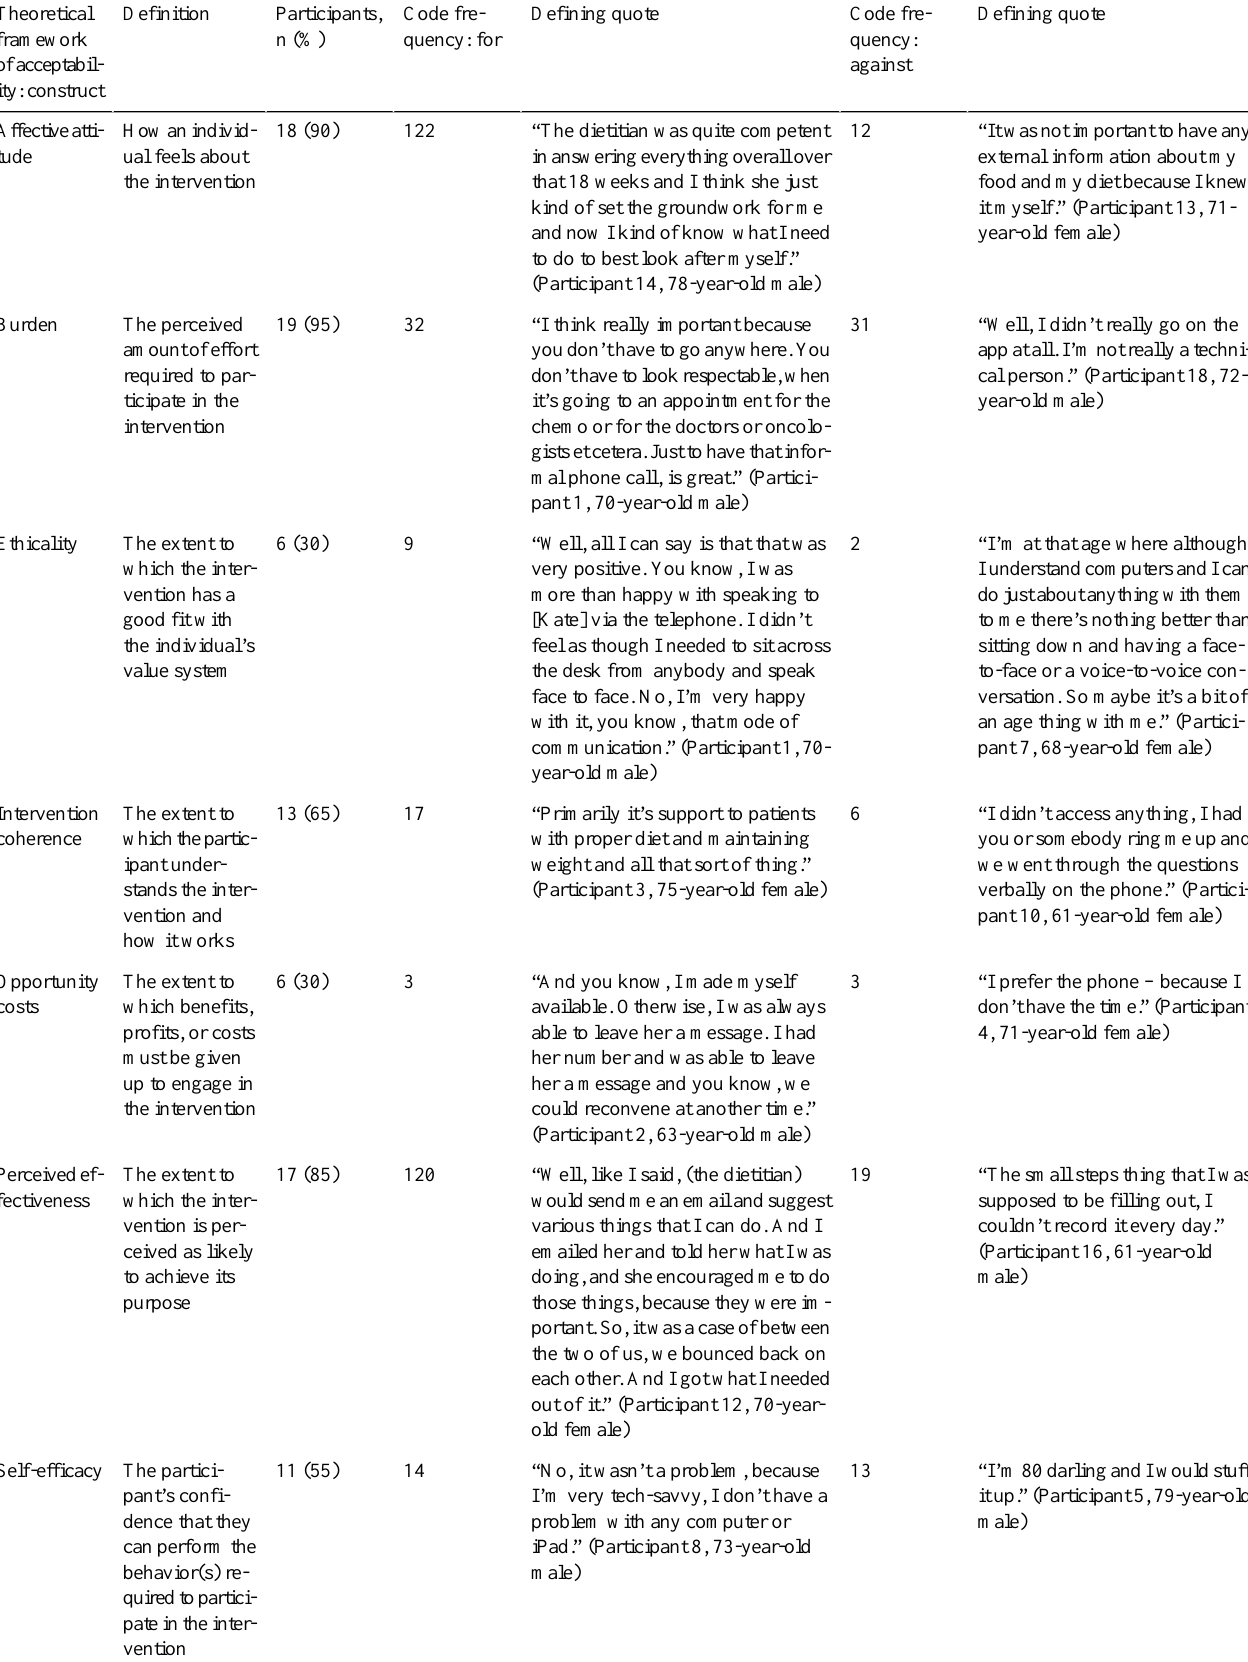
Table 3. Analysis using the Theoretical Framework of Acceptability